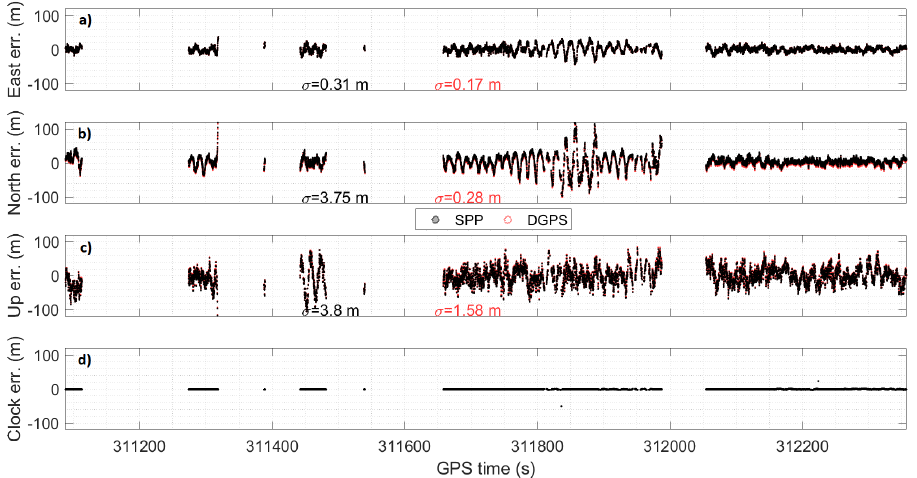
Figure 10. Single-Point (in grey) and DGPS (in red) solution components for test 2 (steering off). Panels ( a – d ) show the East, North, Up, and clock bias components,